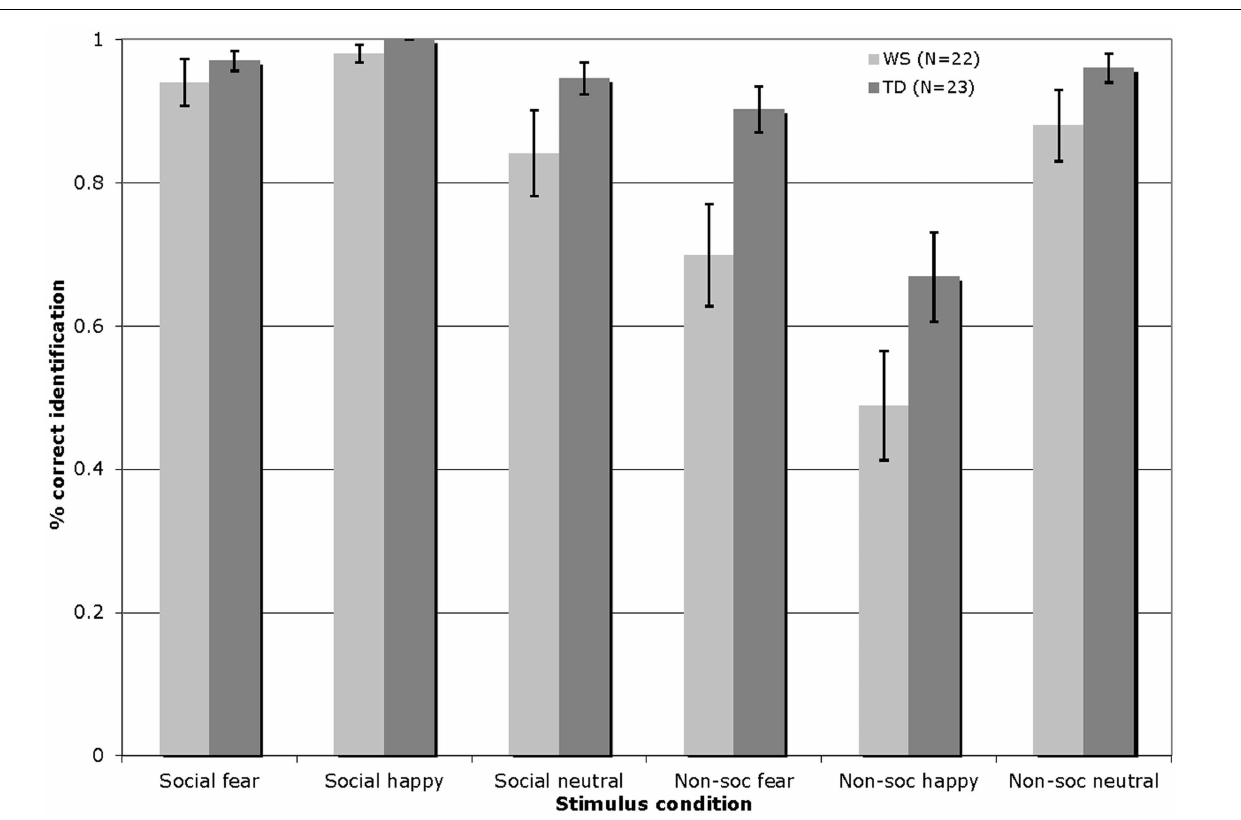
FIGURE 1 |Accuracy of visual affect identification for individuals withWS andTD, across the happy, fearful, and neutral categories for both social